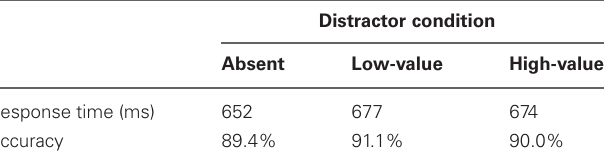
Table 1 | Response time and accuracy by condition in the test